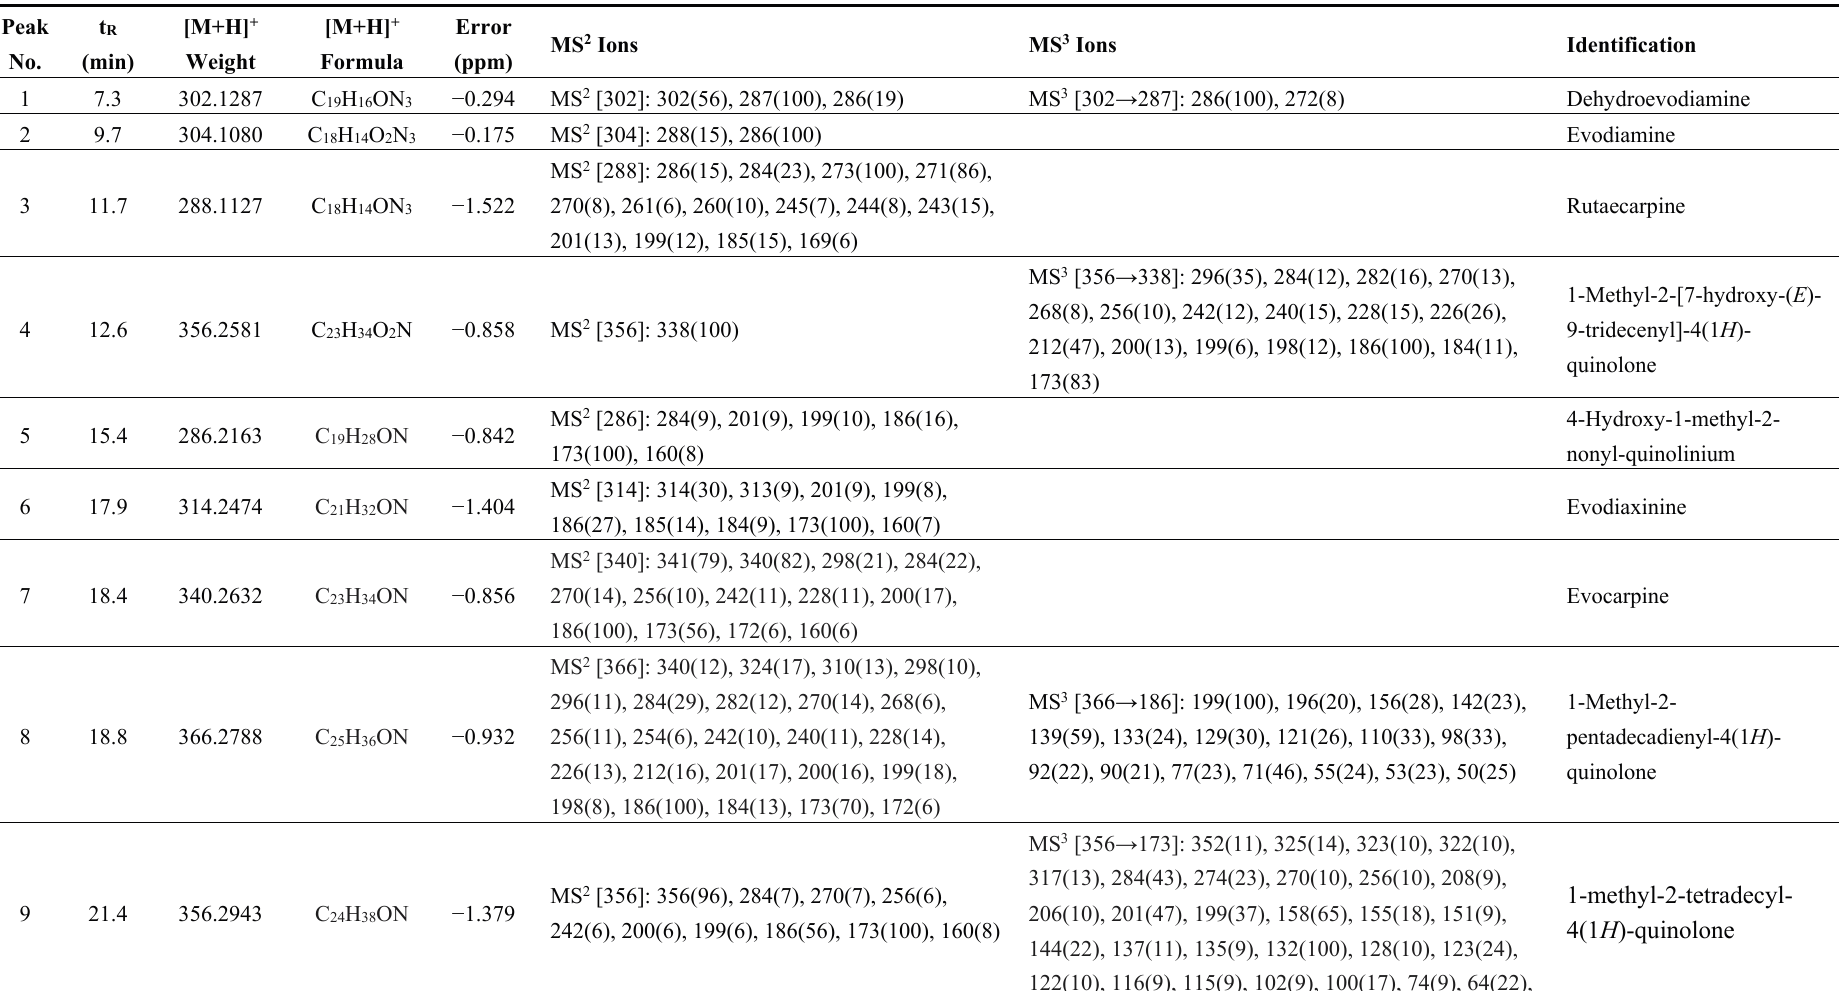
Table 2. Information of retention time ( t R , min), [M+H] + weight, [M+H] + formula, error (ppm) between theoretical and measured values, MS 2 and MS 3 ions of the characteristic